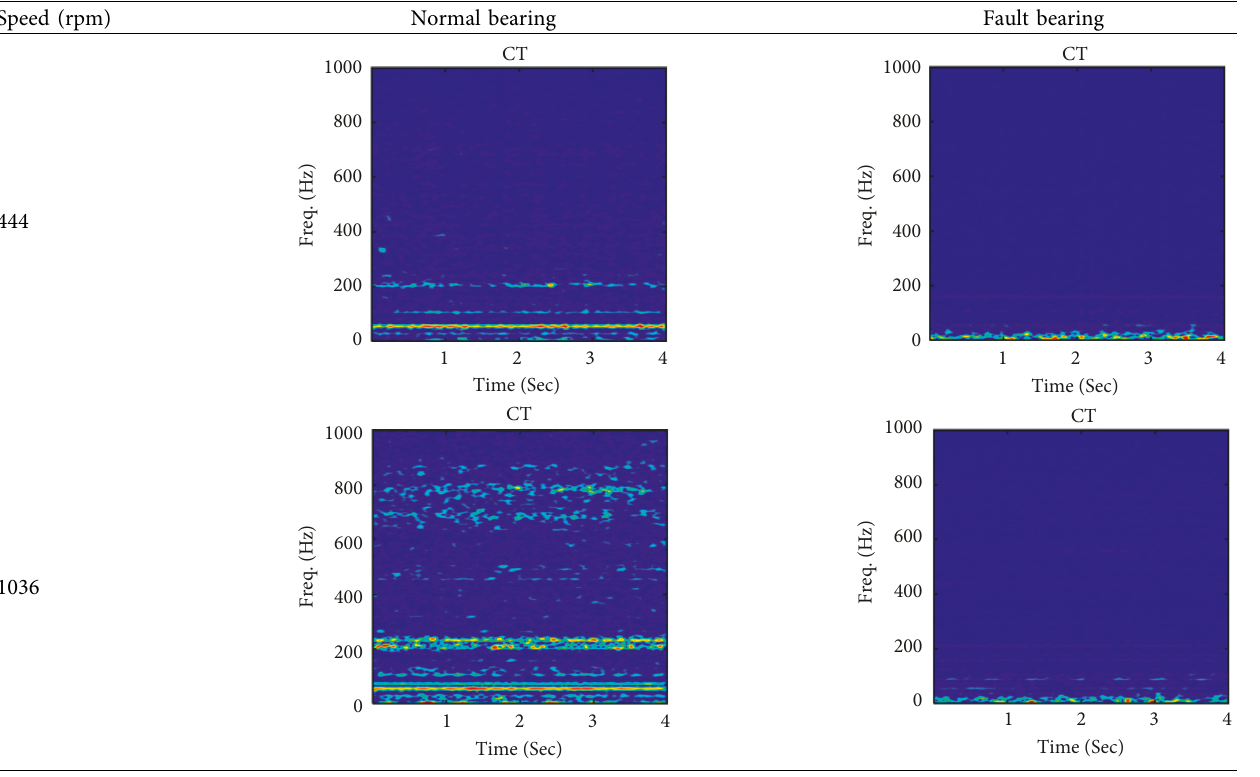
Table 10: Time-frequency diagram of acoustic